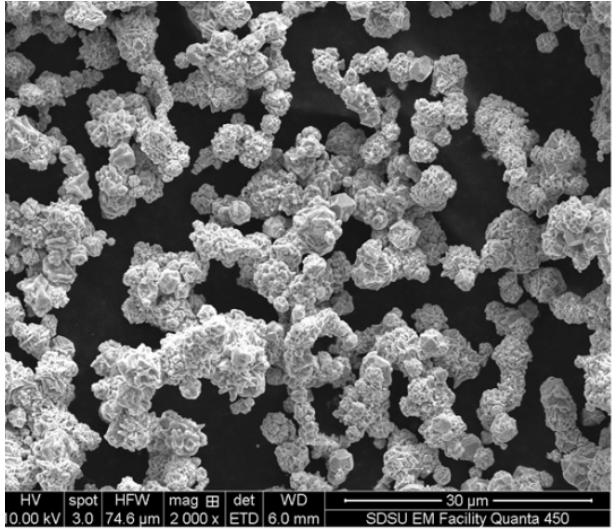
Figure 2. Scanning electron micrograph of INCO 123 nickel